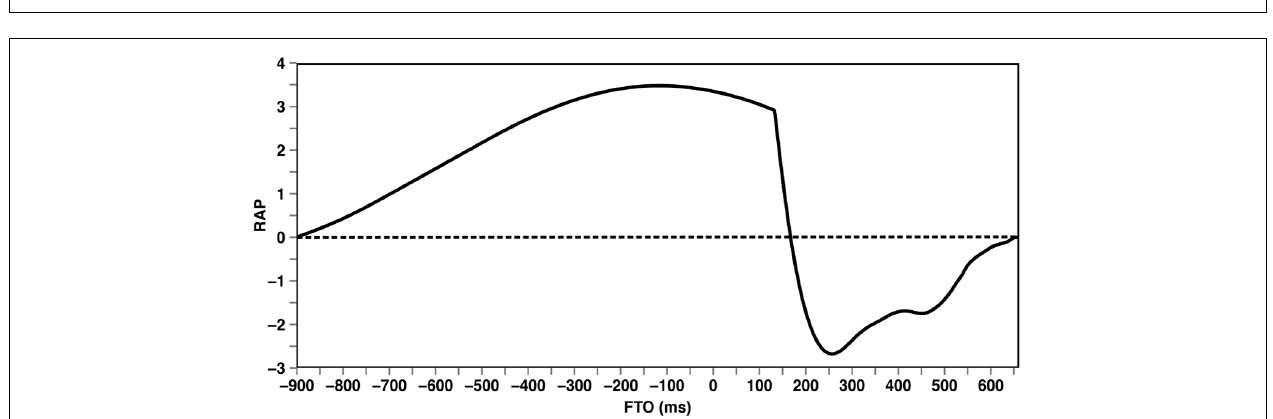
FIGURE 6 | ReactionAnticipation Proportion (RAP) value as a function of the FTO